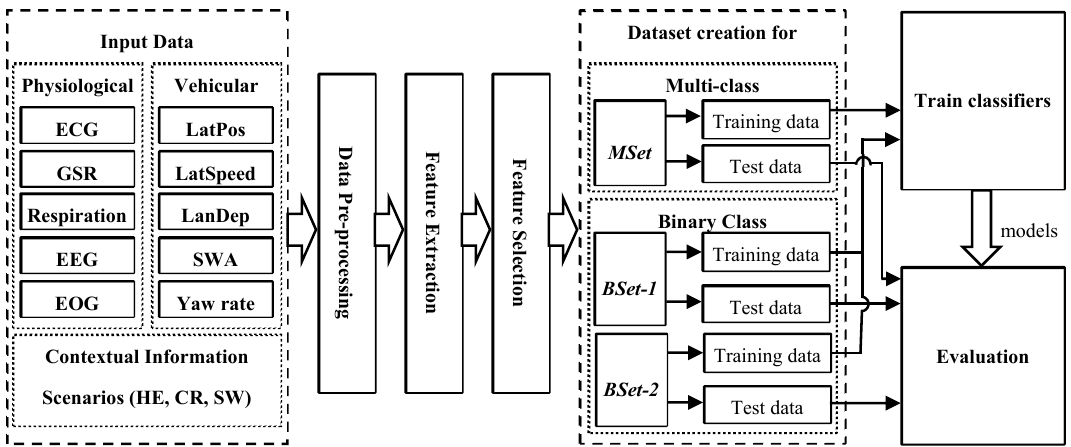
Figure 3. Block diagram of the steps for driver cognitive load classification using multivariate data.